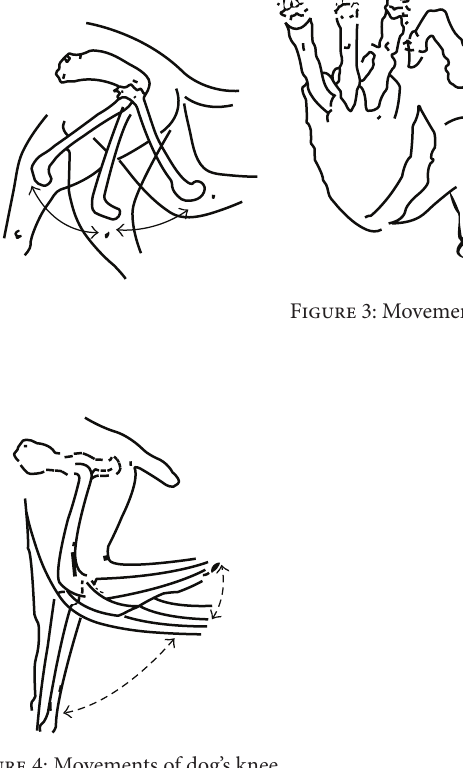
Figure 4: Movements of dog’s knee.